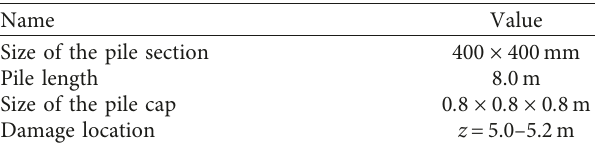
Table 3: Parameters of the pile-soil model.